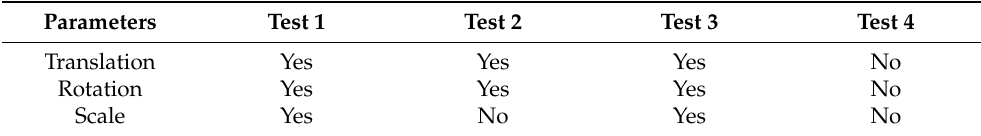
Table 1. Extending NEQs by transformation parameters.